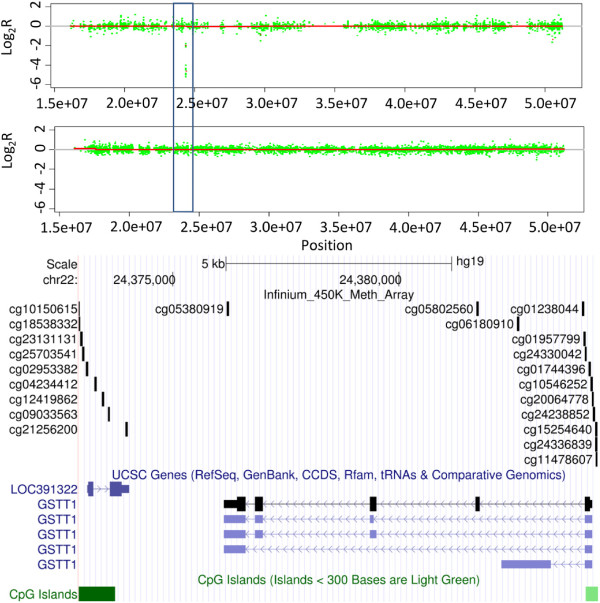
Infinium unique GSTT1 deletion. CN profiles for a proportion of chromosome 22 for a single chondrosarcoma sample generated from Infinium HumanMethylation450 BeadChip (upper panel) and CytoSNP arrays (middle panel). The Infinium array specific deletion of GSTT1 is highlighted (blue box). The lower panel shows the genomic organization of the Infinium unique GSTT1 region of deletion and the distribution of probes on the Infinium methylation, CytoSNP and SNP 6.0 arrays.